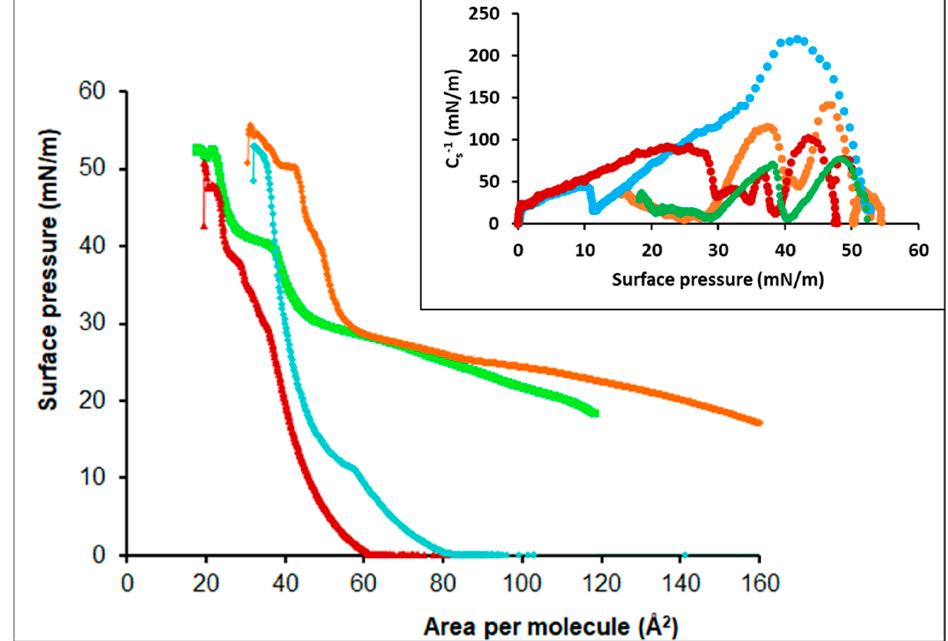
Figure 7. Surface pressure-area isotherms and elastic modulus curves (inset) for OA-DPPC mixtures: X OA = 0.634, in the absence (red) and in the presence (green) of lysozyme; X OA = 0.224, in the absence (blue) and in the presence (orange) of lysozyme. Table 1. Excess area (in Å 2 · molecule − 1 ) (see Equation (2)) for the mixed l í pids at several surface